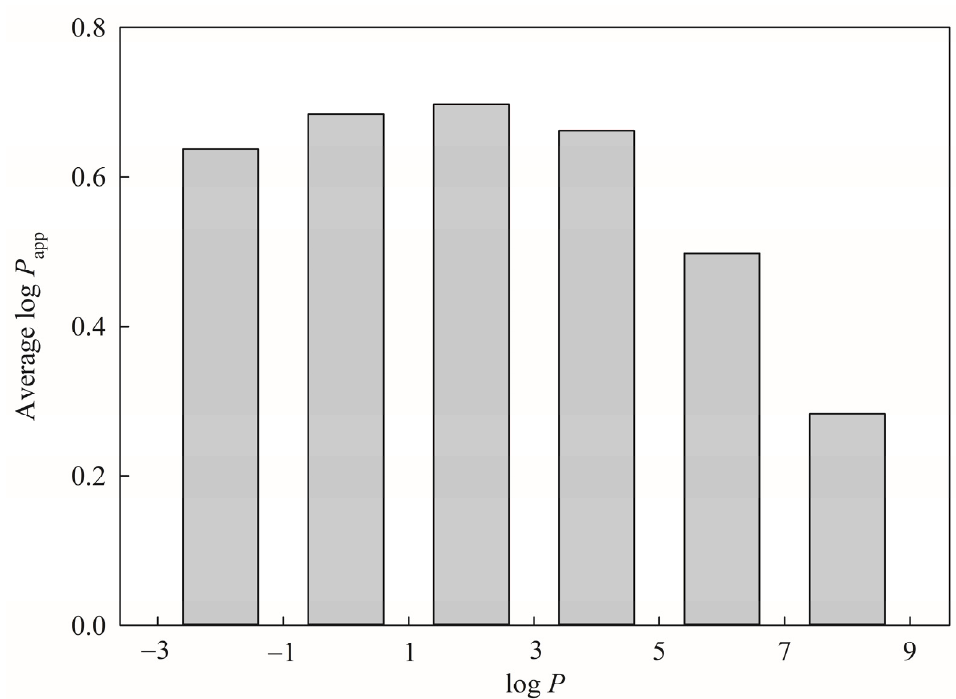
Figure 8. Histogram of average log P app versus the distribution of log P.